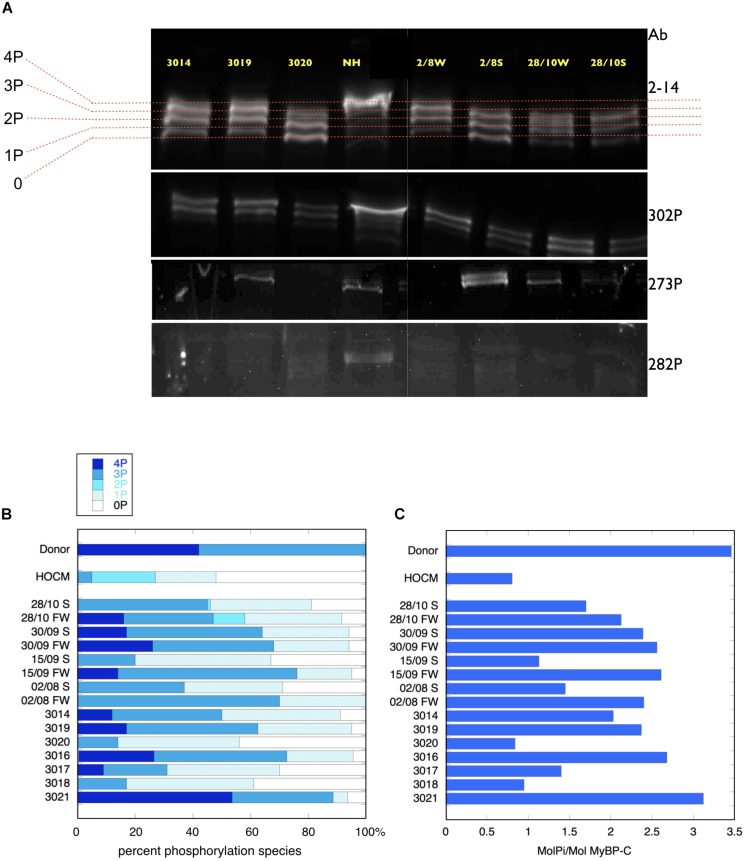
Phosphate affinity SDS-PAGE separation of myofibrils, probed with antibodies to MyBP-C. (A, top) Example of separation of MyBP-C phosphospecies probed with 2–14 pan MyBP-C antibody. NH is a donor heart sample showing a high level of 3P and 4P species. The other lanes are aortic stenosis samples which show less 4P and more 1P and 0P species. (A, lower panels) the same samples probed with antibody specific to phosphorylated ser 302, ser 273 and ser 282. (B) Distribution of 4P, 3P, 2P, 1P, and 0P species of MyBP-C in heart muscle samples. The results for each sample are the means of 2–4 replicate assays. Donor heart NM and HOCM heart MV control results are the mean of replicates included in the same gels as the pressure overload samples. Full data is shown in Supplementary Table 3. S, septum; FW, free wall. (C) Calculated total phosphorylation level for these samples.